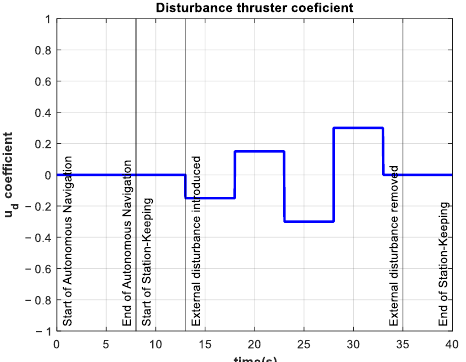
Figure 19. Time-varying additional thruster coefficient in the interval 13 s ≤ 𝑡 ≤ 25 s . Minimum value −0 .25 and maximum value 0.25.